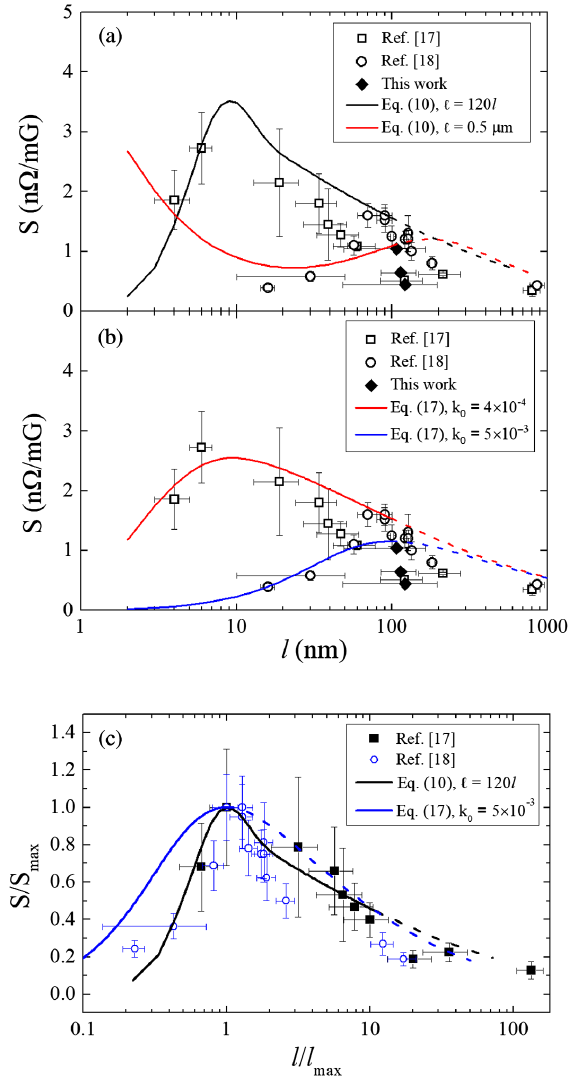
FIG. 11. Trapped flux sensitivity at 1.3 GHz as a function of mean free path. Solid lines are calculated for the case of a vortex normal to the surface pinned by a strong pin (a) or by weak collective pinning (b). Dashed lines are extrapolations to the clean limit for each case. The mean free path values were obtained from M-B fits above 5 K using Halbritter ’ s code. The trapped flux sensitivity data from Refs. [17] and [18] are shown normalized to the respective peak value and plotted as a function of the mean free path scaled to the value at which S is maximum in each data set in